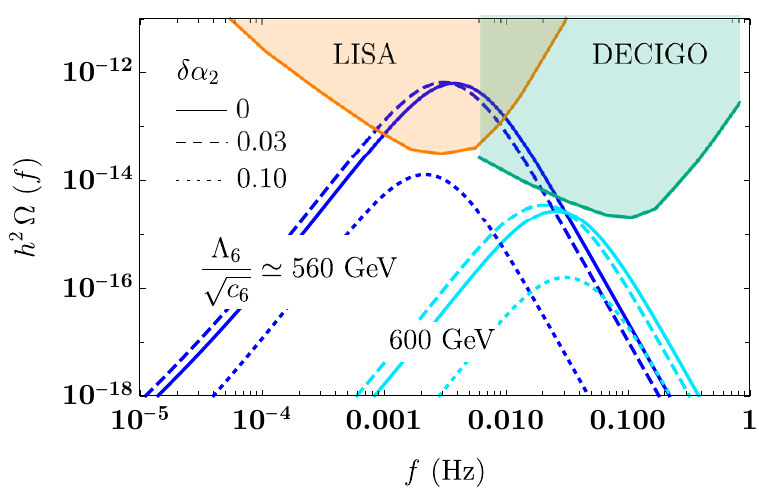
p c 6 = 560 GeV (dark) and